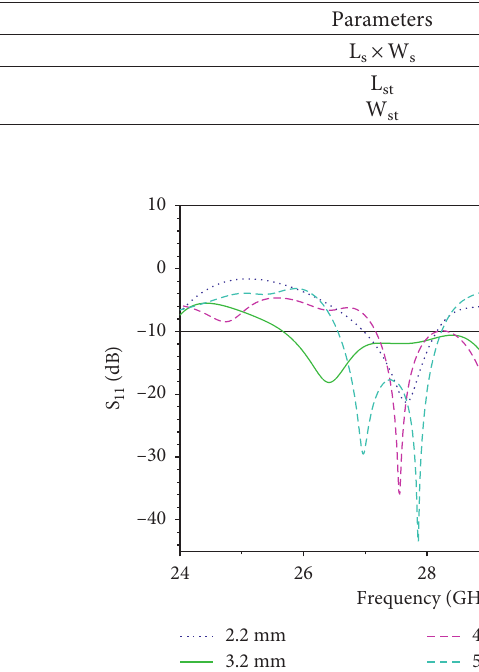
Figure 2: Geometry of series-fed microstrip array antenna. Table 2: Dimensions of the series-fed microstrip array antenna.